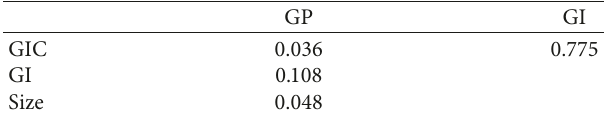
Table 8: Effect sizes ( f 2 ) of the analyzed variables.